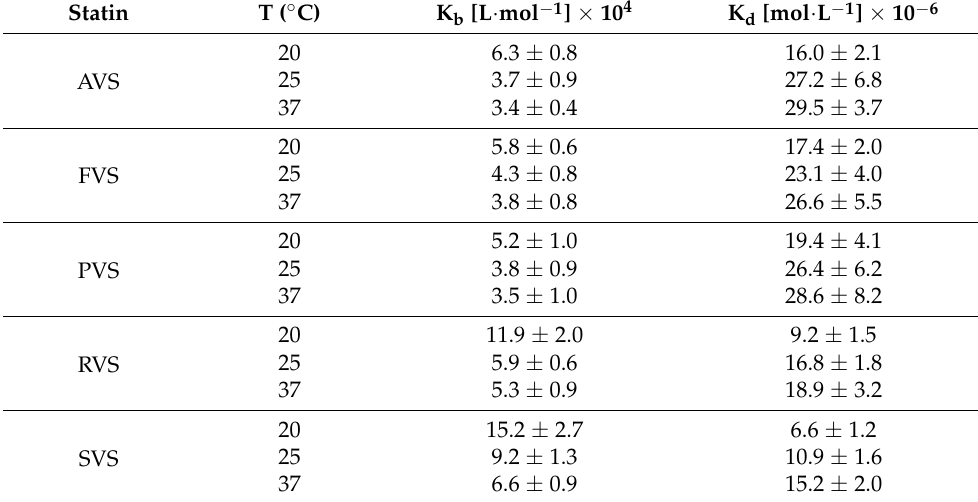
Table 1. Binding parameters of hAK1 at 20, 25 and 37 ◦